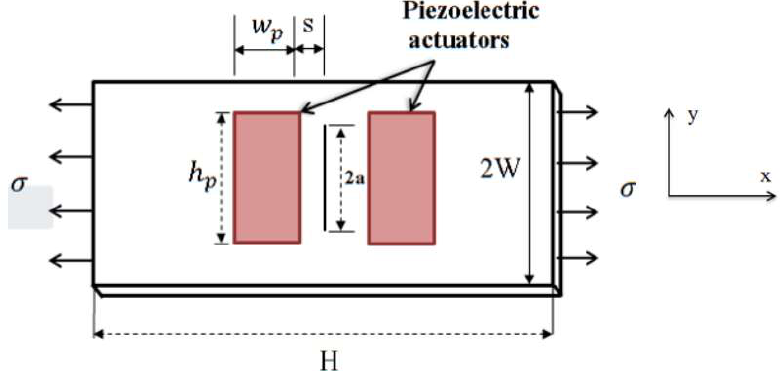
Figure 1. Centre-cracked plate with integrated piezoelectric actuators.